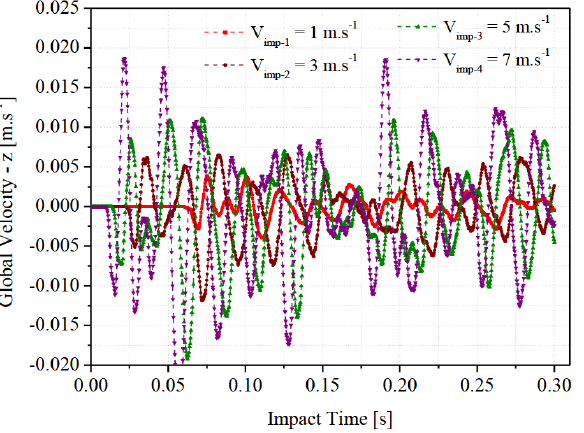
Figure 14: Internal energy of the idealized drum inside the container tween a peak point to others on the vertical direction is wider which indicates that the simultaneous responses on the structures during impact does not